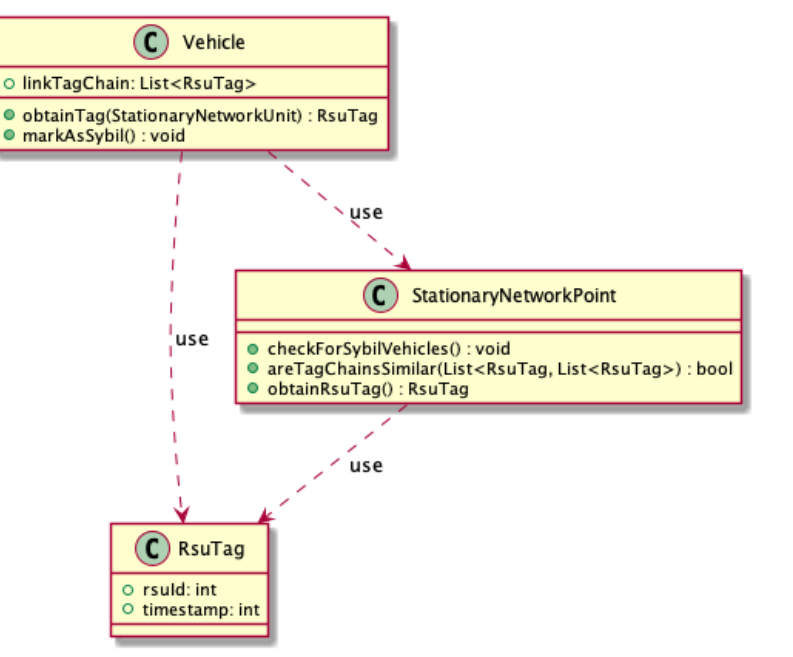
Figure 8. Footprint class